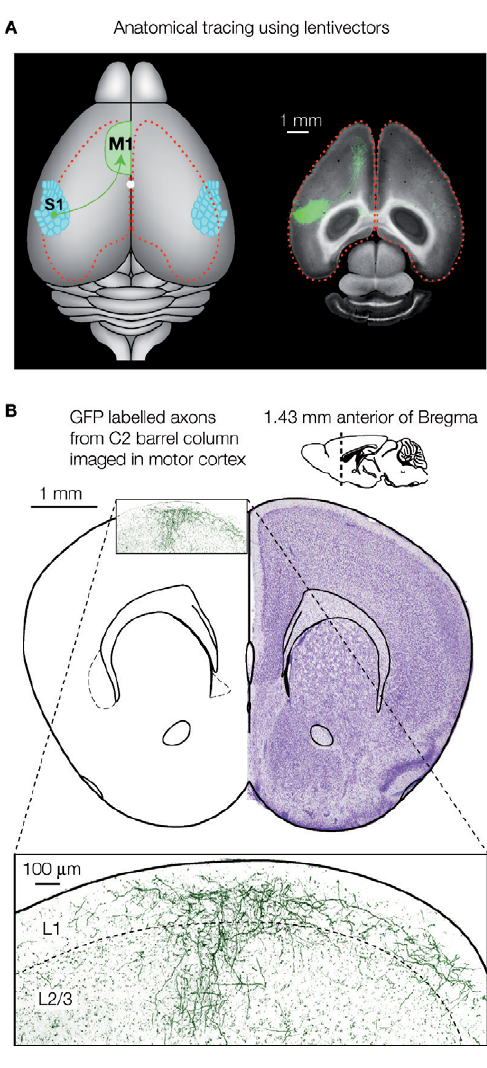
Figure 4 | Axonal tracing using lentivectors. (A) Targeted injection of GFP expressing lentivectors into the mouse C2 barrel column, allows the analysis of the long-range axonal output. A prominent innervation of motor cortex is visualized in horizontal brain slices. (B) GFP labelled axons originating from pyramidal neurons in the C2 barrel column are shown in a coronal section of motor cortex ( ∼ 1.4 mm anterior of Bregma). Panel A modifi ed and reproduced with permission from Ferezou et al. (2007). Copyright from Neuron, Cell Press. Panel B (right) is modifi ed and reproduced with permission from Paxinos and Franklin (2001) The mouse brain in stereotaxic coordinates. Copyright from Academic